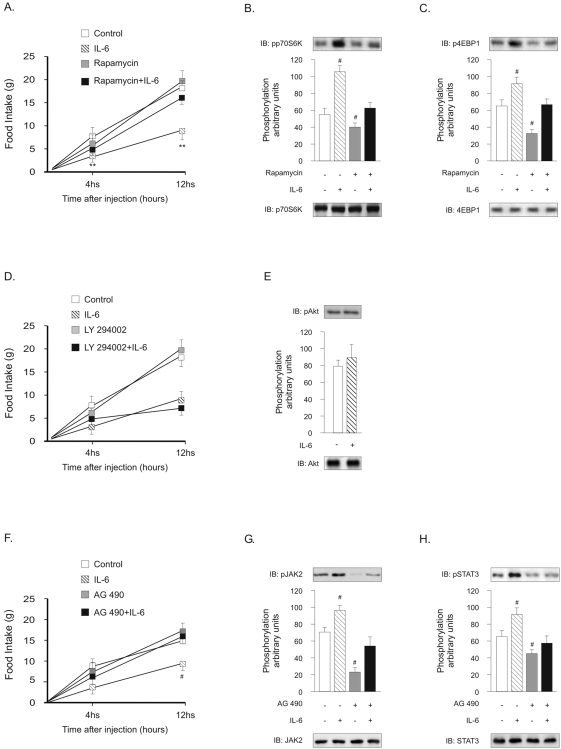
Effects of IL-6 on food intake and hypothalamic PI(3)K/mTOR and JAK/STAT activity.(a) Pretreatment with Rapamycin blocks IL-6-induced anorexia (n = 10–12 animals per group). (b, c) Representative Western blots of four independent experiments showing hypothalamic lysates from Wistar rats. Phospho-p70S6Kinasethr389, threonine phosphorylated p70S6Kinase and total p70S6K (b); phospho-4EBP1thr70, threonine phosphorylated 4EBP1 and total 4EBP1 (c). (d) Pretreatment with LY294002 had no effect on anorectic response to IL-6 (n = 10–12). (e) Representative western blot of four independent experiments showing hypothalamic lysates from Wistar rats. Phospho-Aktser473, serine phosphorylated Akt and total Akt. (f) Pretreatment with AG490 blocks IL-6-induced anorexia (n = 10–12 animals per group). (g, h) Representative Western blots of four independent experiments showing hypothalamic lysates from Wistar rats. Phospho-JAK2, tyrosine phosphorylated JAK2 and total JAK2 (g); phospho-STAT3, Tyrosine phosphorylated STAT3 and total STAT3 (h). Data are the means±SEM. **p<0.01, vs. control group; # p<0.05, vs. other groups.